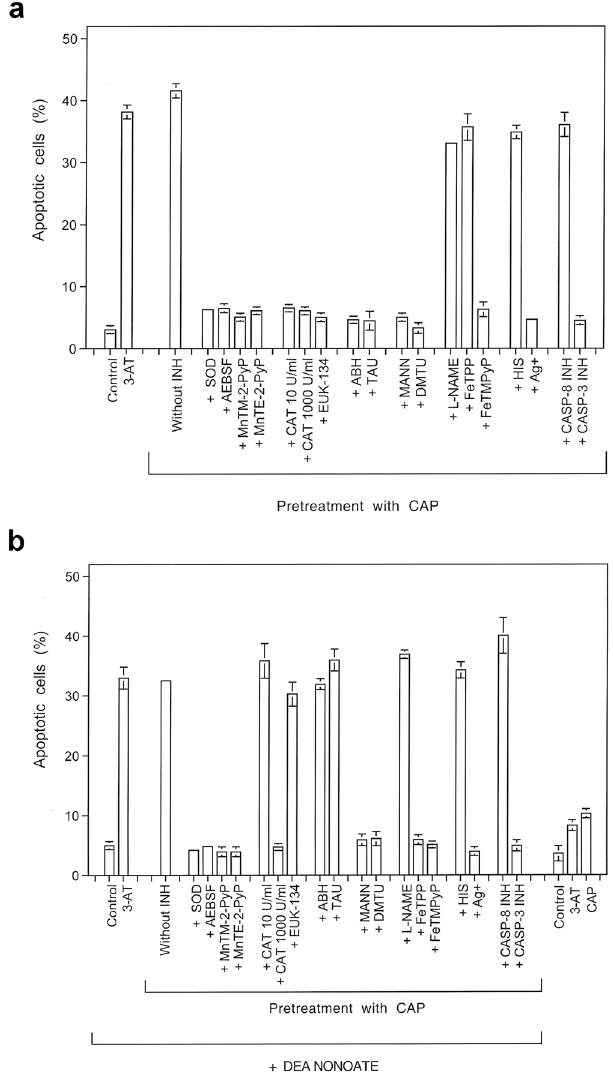
Figure 6. Inactivation of membrane-associated catalase allows for reactivation of intercellular RONS-mediated apoptosis-inducing signaling. ( a ) Catalase inactivation through CAP treatment allows for reactivation of intercellular apoptosis-inducing HOCl signaling. Control assays: MKN-45 cells received 100 mM of the catalase inhibitor 3-AT or remained untreated (“control”) and were then incubated for 3.5 h. CAP pretreatment: MKN- 45 cells were pretreated with CAP for 1 min, incubated in the same medium for 25 min and then subjected to three washing cycles. The cells received either no inhibitors or were cultivated in the presence of the indicated inhibitors for 3.5 h, before the percentages of apoptotic cells were determined. SOD and the SOD mimetics MnTM-2-Pyp or MnTE-2-PyP scavenge superoxide anions (O 2 ⋅− ) and generate H 2 O 2 , AEBSF prevents O 2 ⋅− generation by NOX1, catalase and the catalase mimetic EUK-134 decompose H 2 O 2 , 4-aminobenzoyl hydrazide (ABH) inhibits peroxidase, taurine (TAU) scavenges HOCl, mannitol (MANN) and dimethyl urea (DMTU) scavenge ⋅ OH radicals, L-NAME inhibits NOS, FeTPPS selectively decomposes peroxynitrite (ONOO − ), FeTMPyP decomposes ONOO − and scavenges O 2 ⋅− , histidine (HIS) scavenges 1 O 2 , Ag + inhibits aquaporins, caspase inhibitor specifically inhibit caspase-8 or caspase-3. Please find the respective inhibitor concentrations in Table 1. The results show that pretreatment with CAP plus incubation has the same effect as inhibition of catalase with 3-AT. Cell death after catalase inactivation by CAP is mediated by HOCl signaling, depends on aquaporine activity and is executed through caspase-3. It does not require ⋅ NO/ONOO − signaling, caspase-8 or the action of 1 O 2 . Statistical analysis: Apoptosis induction after CAP treatment, as well as inhibition by all inhibitors except L-NAME, FeTPPS, histidine and caspase-8 inhibitor was highly significant (p < 0.001). ( b ). The effect of the ⋅ NO donor DEA NONOate on intercellular apoptosis-inducing signaling after catalase inactivation by CAP treatment. Assays without pretreatment (“control”), treated with 25 mM of the catalase inhibitor 3-AT or with CAP for 1 min, followed by 25 min incubation, three cycles of washing and addition of the indicated inhibitors received 0.5 mM of the ⋅ NO donor DEA NONOate. Parallel controls without pretreatment or treated with 3-AT or CAP remained free of DEA NONOate (Controls of the right side of the panel). The percentages of apoptotic cells were determined 2 h after addition of the ⋅ NO donor. The results show that the addition of the ⋅ NO donor had shifted apoptosis inducing signaling by cells with inactivated